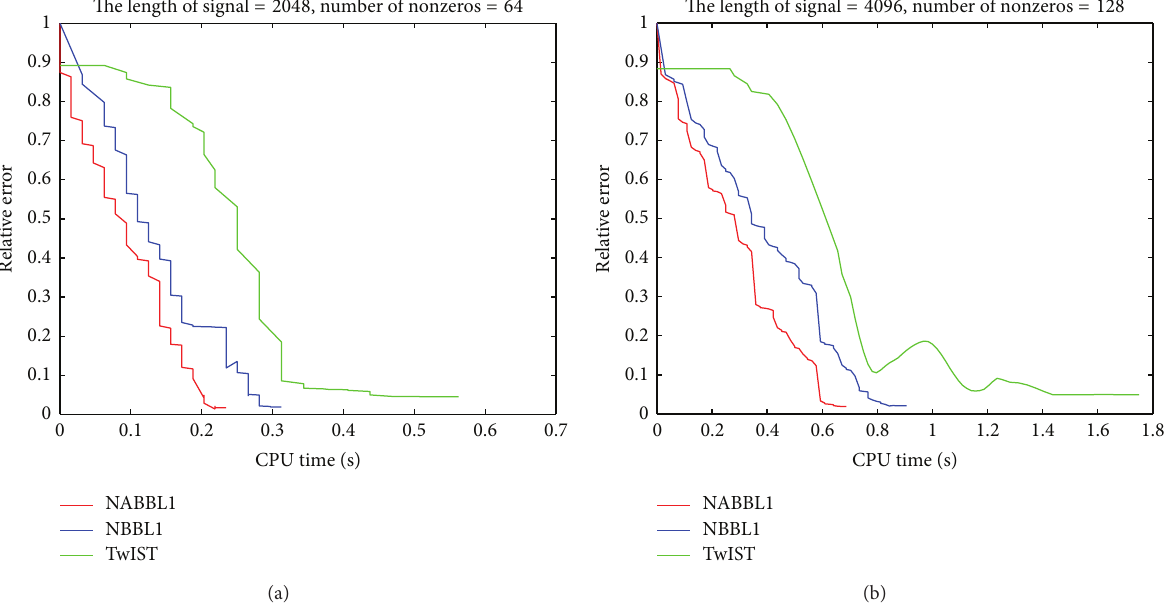
Figure 2: Comparison result of NABBL1, NBBL1, and TwIST with 𝜎 2 = 10 −3 . (a) Original signal with length of 2048 and 64 nonzero elements. (b) Original signal with length of 4096 and 128 nonzero elements. The 𝑥 -axes represent the CPU time in seconds. The 𝑦 -axes represent the relative